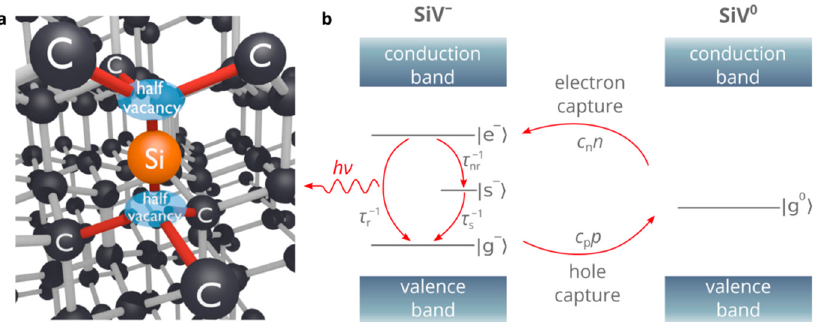
Figure 1. ( a ) Ball-and-stick model of the silicon-vacancy (SiV) center in diamond. ( b ) Diagram of the single-photon electroluminescence process of the SiV center in diamond after Fedyanin and Agio [9]. |g − >, |e − > and |s − > represent the ground, excited and shelving states of the negatively charged SiV center and |g 0 > indicates the ground state of the neutral SiV center. The transitions among the states are shown by arrows and the transition rates are indicated next to them. The notations are the same as in Equation (1).